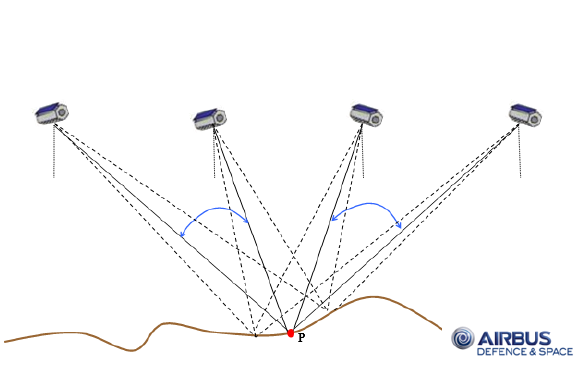
Figure 1. Satellite geometry for RSGCPs®.